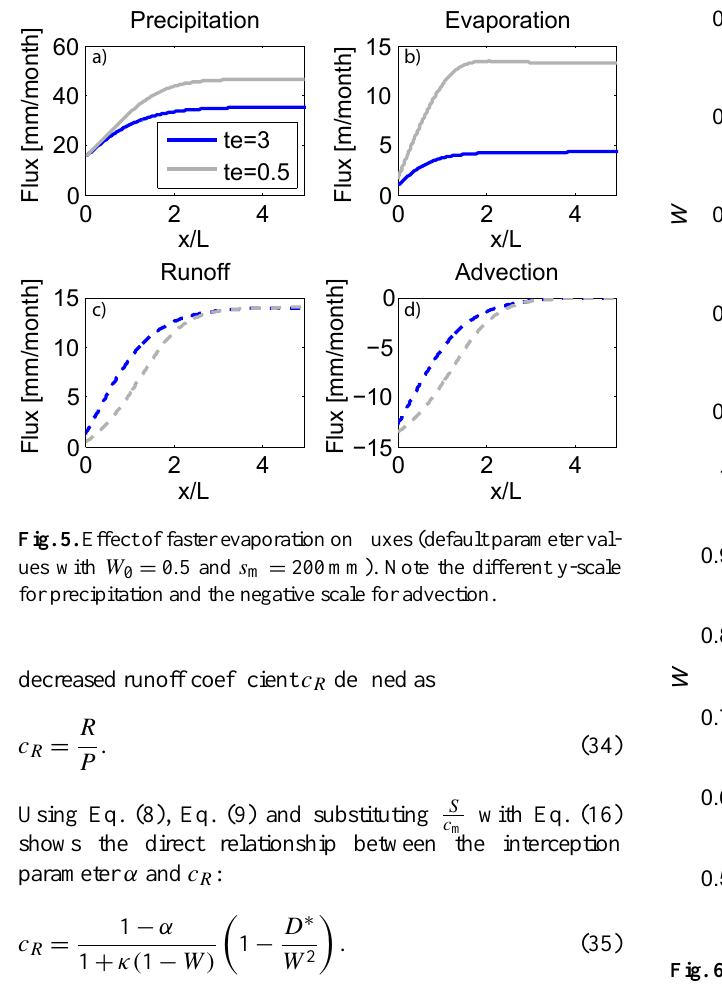
Fig. 6. Moisture profile modifications and regimes switches due to parameter changes (parameter units as in Table 2), top: for changes of τ p ,τ e ,α in x 1 , bottom for a change of τ e in two different locations x 2 < x 1 and x 3 > x 1 ; note the role of α in the switch induced with the parameter set τ p =10 days, τ e =6 months (top